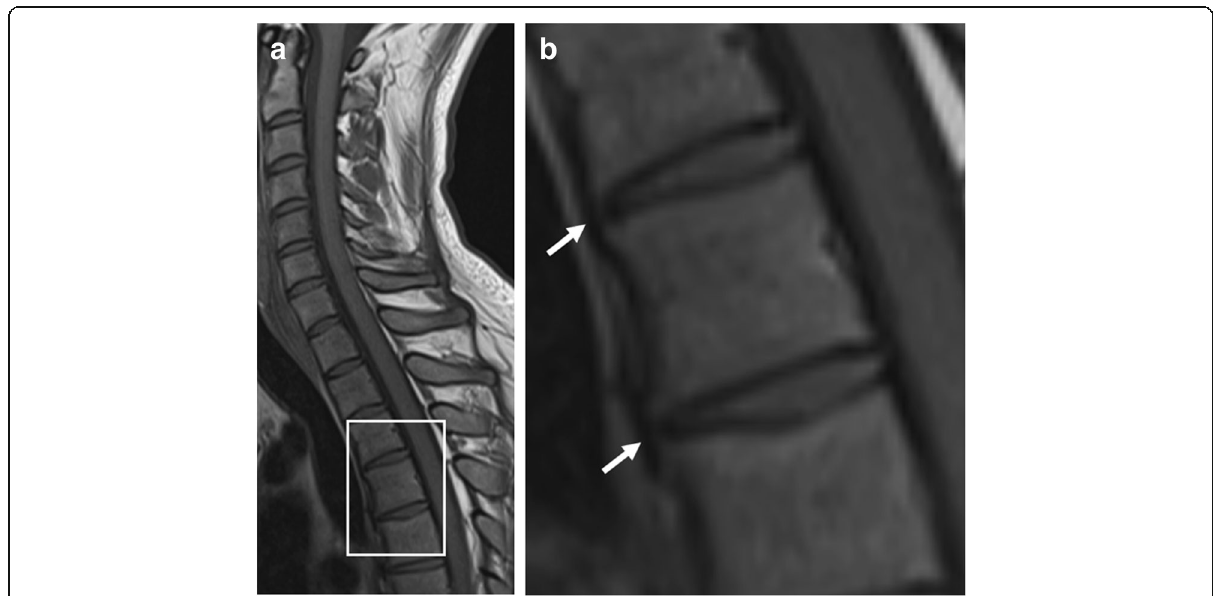
Fig. 6 Non-bridging syndesmophytes. Sagittal T1-weighted MR image shows anterior syndesmophytes (arrows) in a patient without SpA. No other disco-vertebral units besides Th3-Th4 and Th4-Th5 show bony changes. Note: b is an enlargement of the region outlined in a